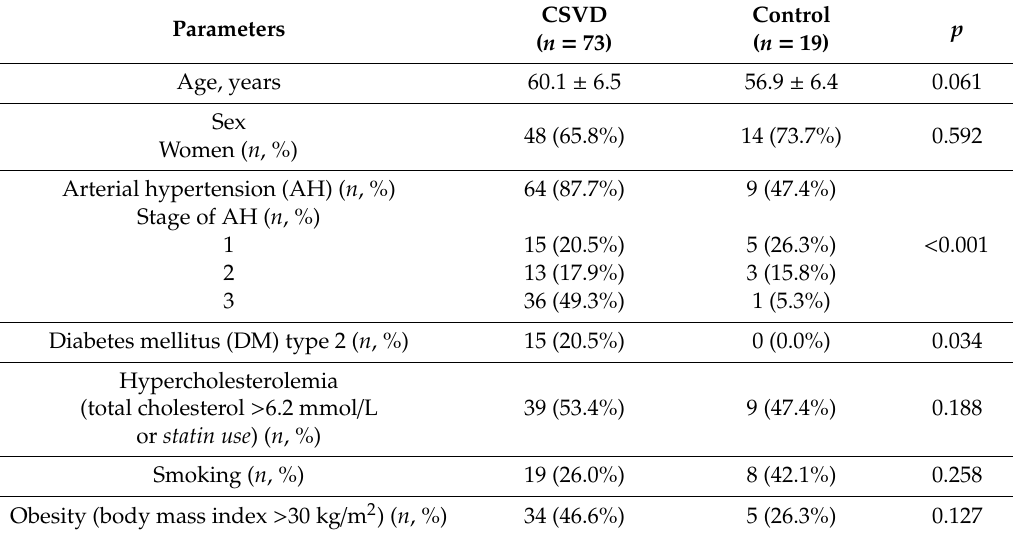
Table 1. Main demographic parameters and risk factors in patients with cerebral small vessel disease (CSVD) and in the control group.